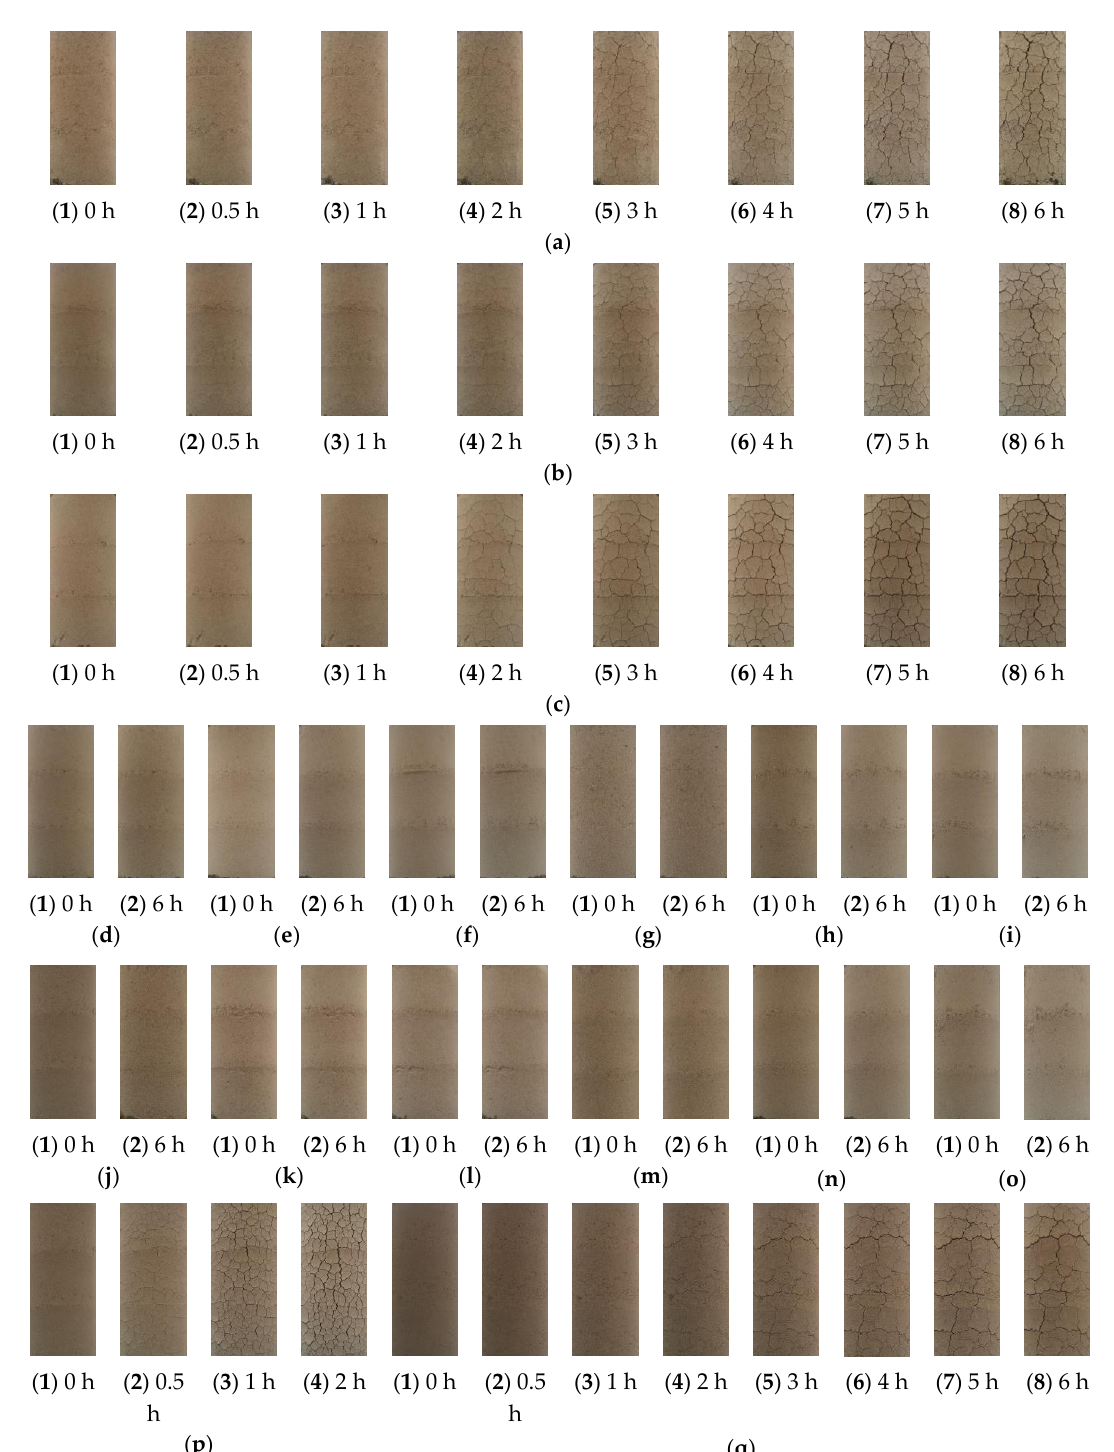
Figure 6. Surface cracks in unslaked and slaked specimens: ( a ) T = 0 h, M = 10%, W = 18%; ( b ) T = 0 h, M = 15%, W = 18%; ( c ) T = 0 h, M = 20%, W = 18%; ( d ) T = 12 h, M = 10%, W = 18%; ( e ) T = 12 h, M = 15%, W = 18%; ( f ) T = 12 h, M = 20%, W = 18%; ( g ) T = 24 h, M = 10%, W = 18%; ( h ) T = 24 h, M = 15%, W = 18%; ( i ) T = 24 h, M = 20%, W = 18%; ( j ) T = 48 h, M = 20%, W = 18%; ( k ) T = 48 h, M = 15%, W = 18%; ( l ) T = 48 h, M = 20%, W = 18%; ( m ) T = 72 h, M = 10%, W = 18%; ( n ) T = 72 h, M = 15%, W = 18%; ( o ) T = 72 h, M = 20%, W = 18%; ( p ) T = 0 h, M = 20%, W = 14%; ( q ) T = 0 h, M = 20%, W = 22%.